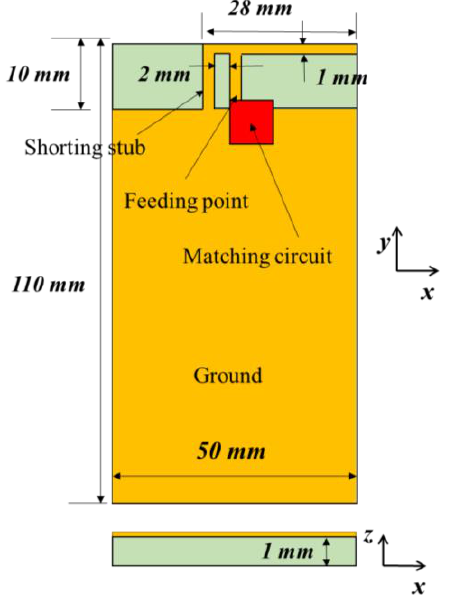
Figure 1. Antenna structure for impedance simulation.